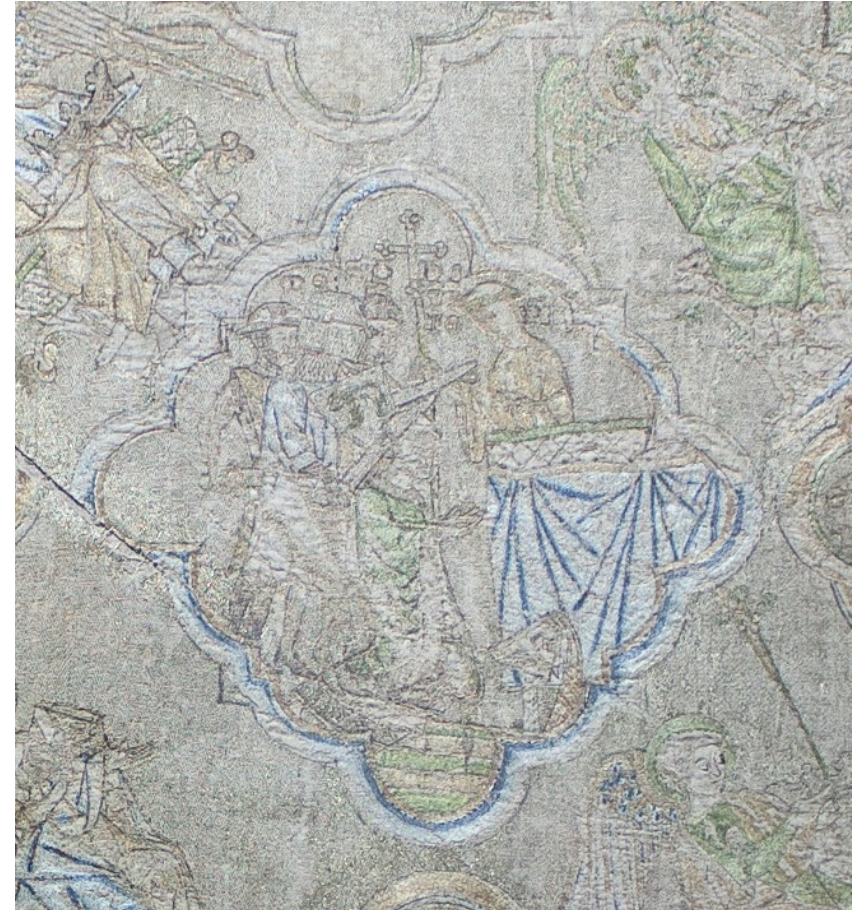
Figure 15. Anagni Cope, detail of Becket’s martyrdom, second half of the 13th century. Ancient treasury of Anagni Cathedral, now in the cathedral museum, Italy. © by concession of the Chapter of the Basilica Cathedral of Anagni. Photo: Graframan.com.